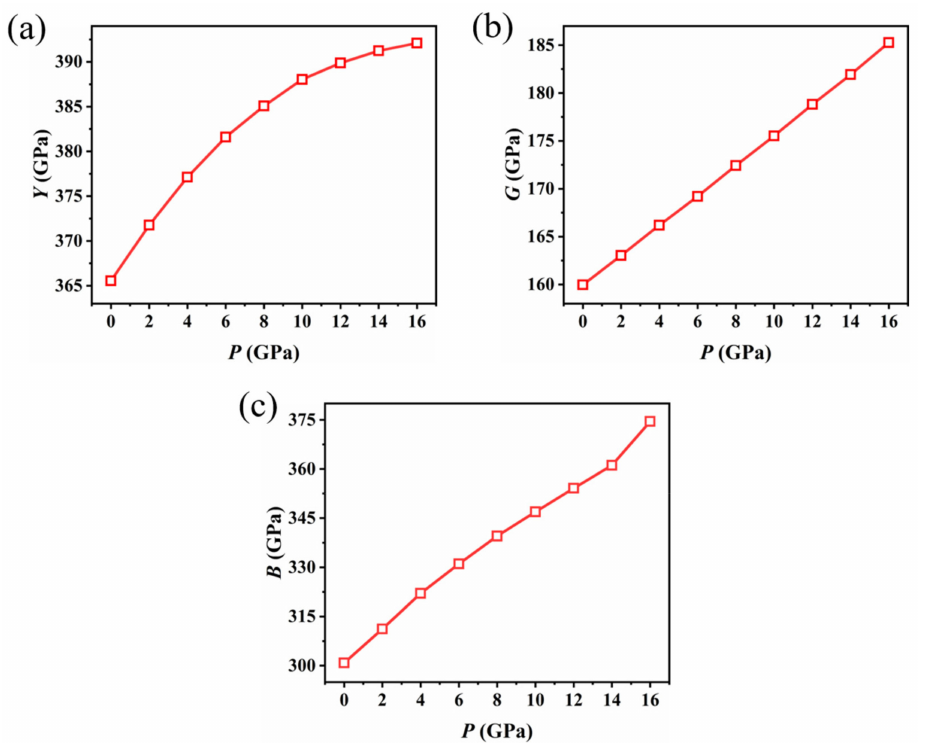
Figure 5. ( a ) Young’s modulus, ( b ) shear modulus, and ( c ) bulk modulus of bulk single-crystal tungsten as a function of pressure.